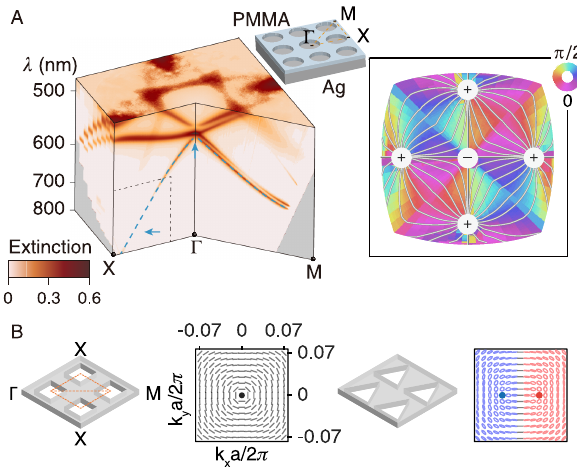
Figure 3: (A) Direct observation of polarization singularities in the far field of a square-lattice plasmonic crystal in the form of absorption spectra. Left: the measured band structure of the plasmonic crystal. Right: the reconstructed far-field polarization field on band 1 of the plasmonic crystal, showing existence of five vector polarization singularities. (B) An example of spawn of circularly polarized states (C-points) from a vector polarization singularity (V-point) in the momentum-space polarization field of a photonic crystal slab. When the holes are transformed from squares to isosceles triangles, the V-point correspondingly separated into two C-points. (A) is adapted from [81] and (B) is adapted from